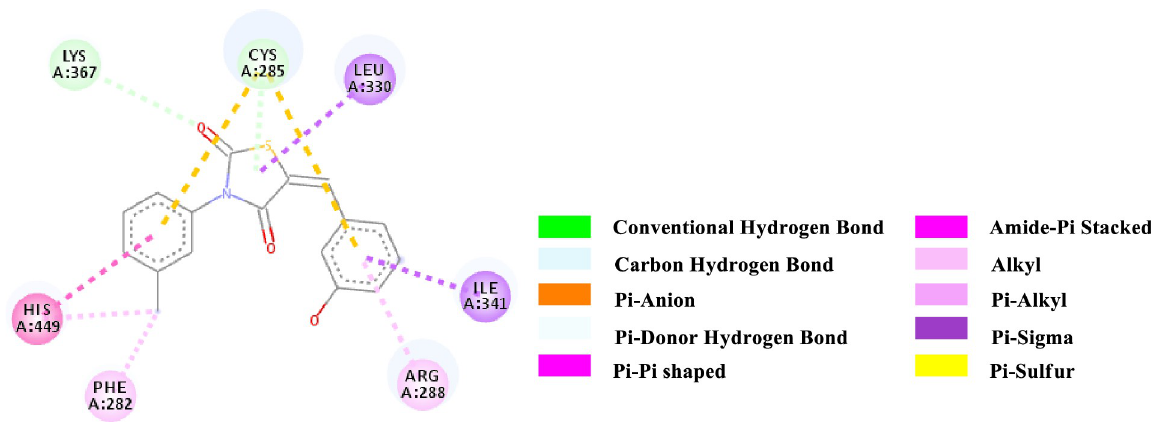
Fig 8. 2D-representation of the non-covalent interactions of 7d with receptor (3gbk) after flexible docking.